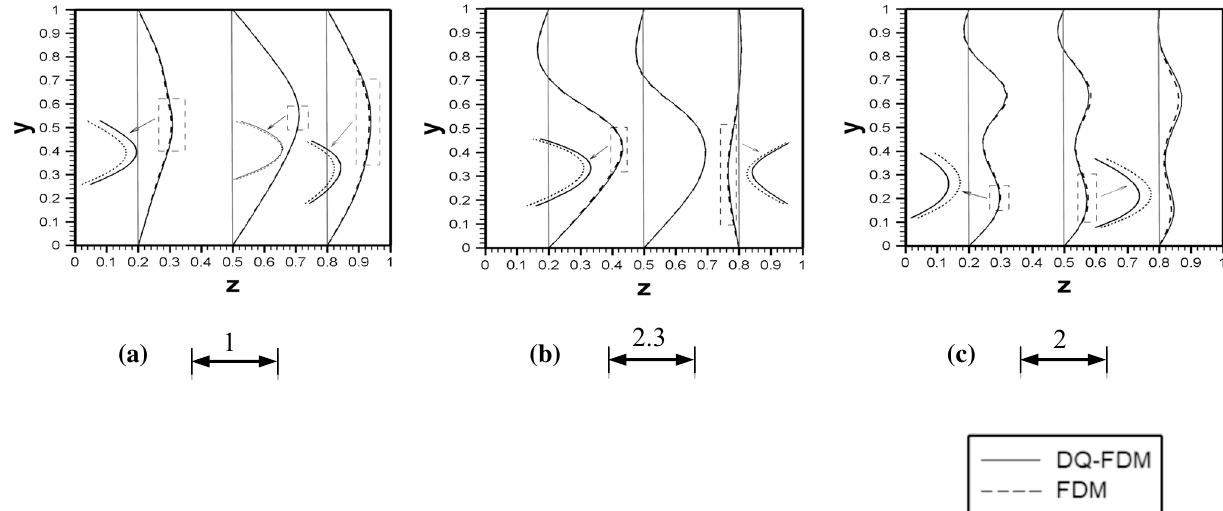
Fig. 6 A sample of comparing the distribution of the velocity of the a longitudinal (u), b depth (v) and c transverse (w) along the depth and for passing plate through the middle of the length (t = 0.05,